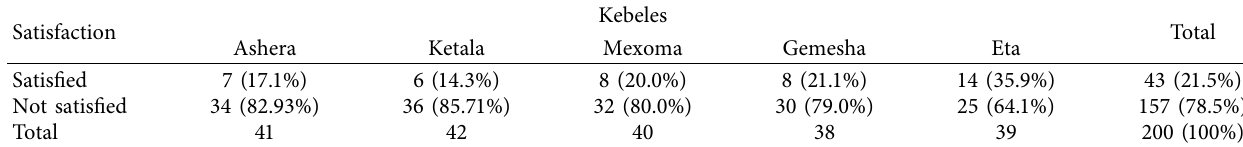
Table 9: Satisfaction of the respondents with the complete AI services in the study area. Satisfaction